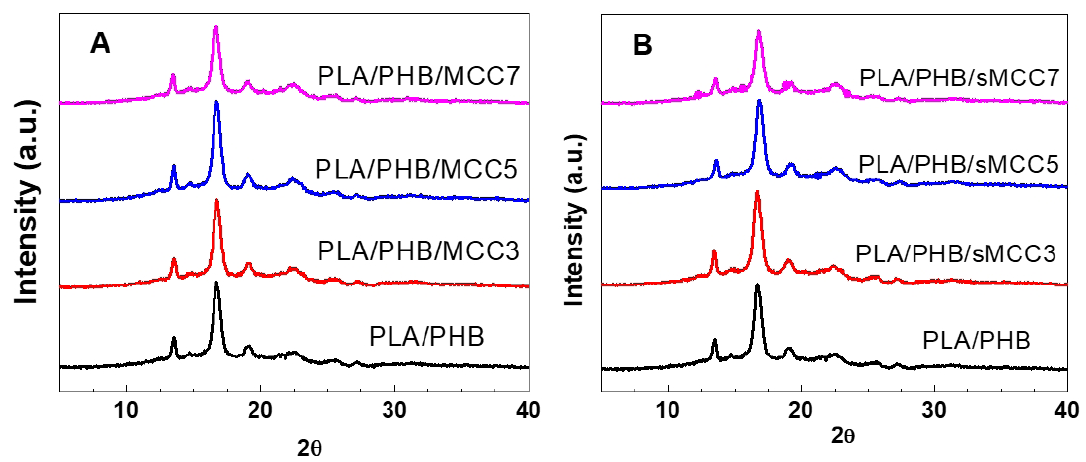
Figure 3. XRD diffractograms obtained for biocomposites systems containing MCC (A) and sMCC